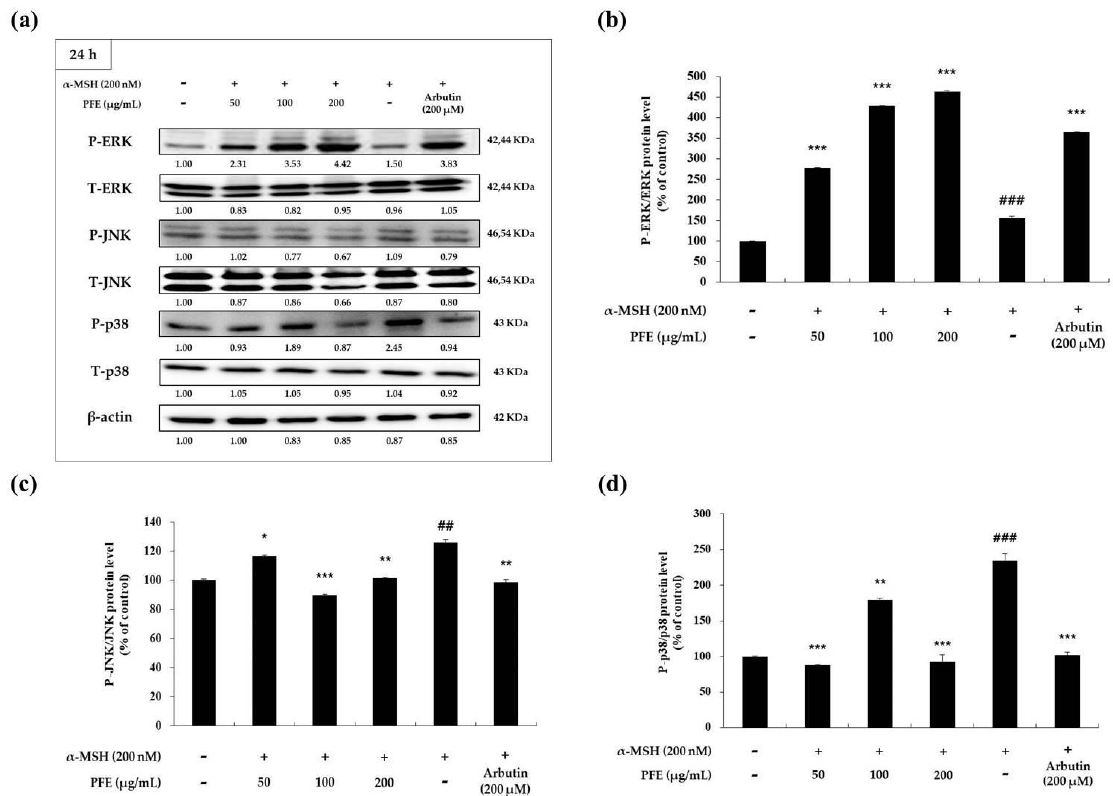
Figure 5. Variation in mitogen-activated protein kinase (MAPK) expression of B16F10 cells to PFE treatment concentration. The cells, α -MSH-stimulated, were treated with the PFE and arbutin (200 µ M) for 40 h. ( a ) The band of MAPK and the graph by quantified protein levels of ( b ) phospho-extracellular signal regulated kinase (P-ERK)/ERK, ( c ) phosphor-c-Jun N-terminal kinase (P-JNK)/JNK, and ( d ) P-p38/p38. Results in each graph are represented as the mean ± SD of at least triplicate experiments. ## p < 0.01, ### p < 0.001 vs. non-treated. * p < 0.05, ** p < 0.01, *** p < 0.001 vs. α -MSH-treated alone. P: phosphorylated; T: total.